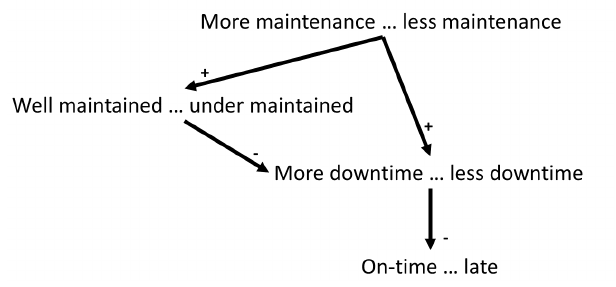
Figure 3. Example of cognitive map used in